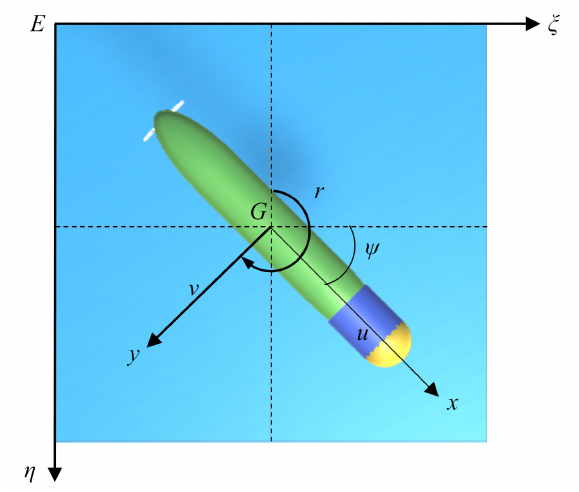
Figure 1. Major components of the AUV. Table 2. AUV parameters.